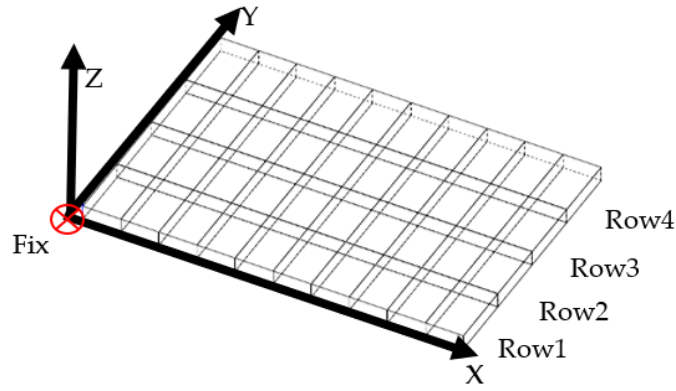
Figure 3. Element divisions of the simulation panel.